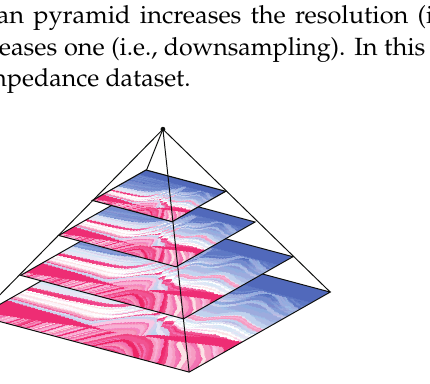
Figure 1. Image pyramid. From up to down, the resolution is lower than the next